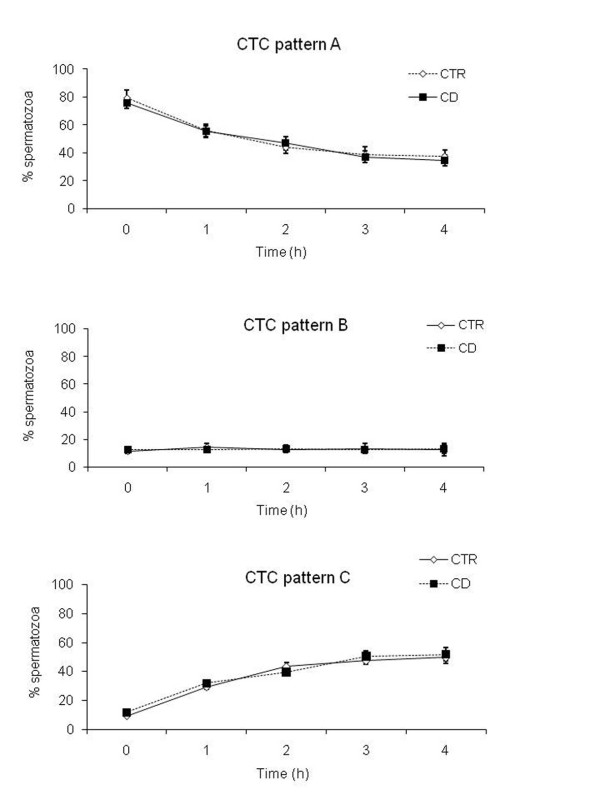
Kinetic of acquisition of CTC staining pattern A, B and C in CTR and CD treated spermatozoa. Graphic showing the percentage of spermatozoa displaying the CTC pattern A, B and C, during the 4 h of incubation under control conditions (dark continue line) or in the presence of CD (dark dot line). All the values are represented as mean ± SD.